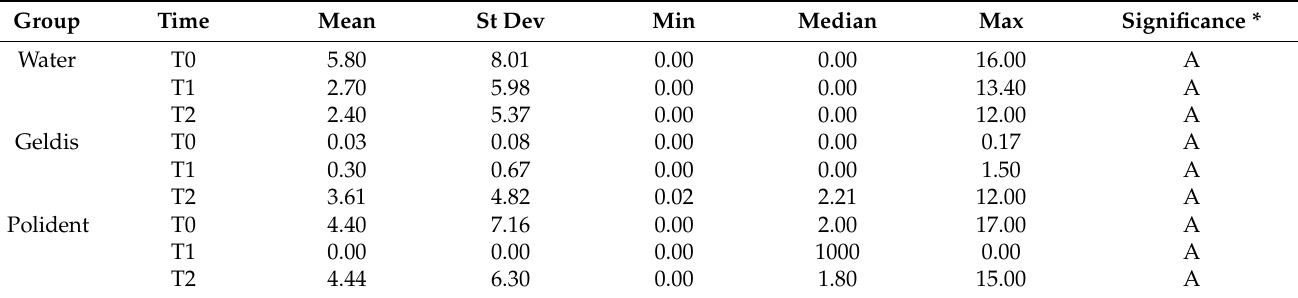
Table 5. Descriptive statistics of Total Pathogen loads